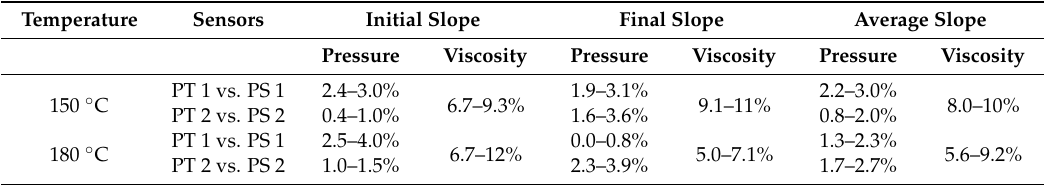
Table 2. Differences (in %) between the pressures measured with piezoelectric (PS) and conventional transducers (PT), and between the corresponding computed viscosities.